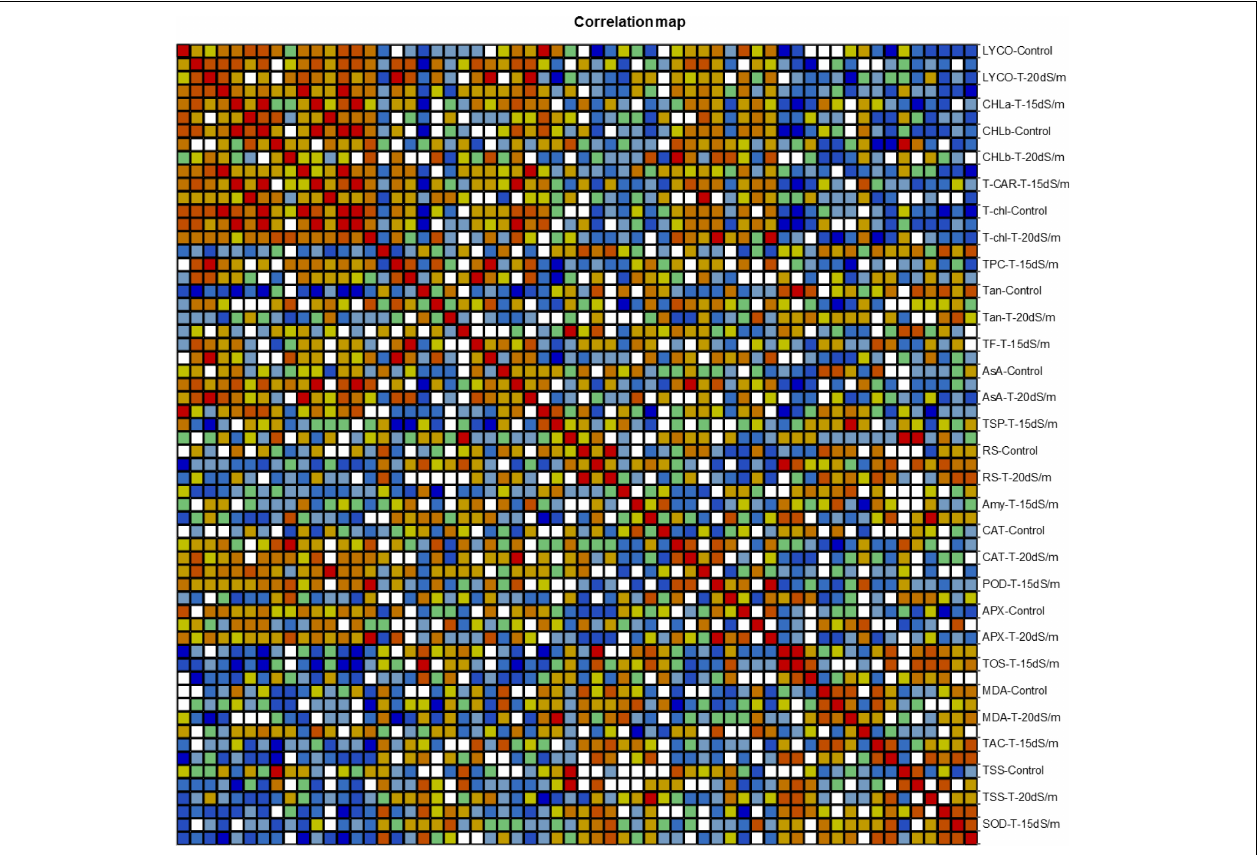
FIGURE 13 | Correlation matrix showing Pearson’s correlation among biochemical traits in cotton genotypes under stress and non-stress conditions. LYCO, lycopene content; CHL-a, chlorophyll a; CHL-b, chlorophyll b; T-CAR, total carotenoids; T-chl, total chlorophyll; TPC, total phenolic content; Tan, tannins; TF, total flavonoids; AsA, ascorbic acid; TSP, total soluble protein; RS, reducing sugar; Amy, amylase; CAT, catalase; POD, peroxidase; APX, ascorbate peroxidase; TOS, total oxidant status; MDA, malondialdehyde; TAC, total antioxidant status; TSS, total soluble sugar; SOD, superoxide dismutase Cluster